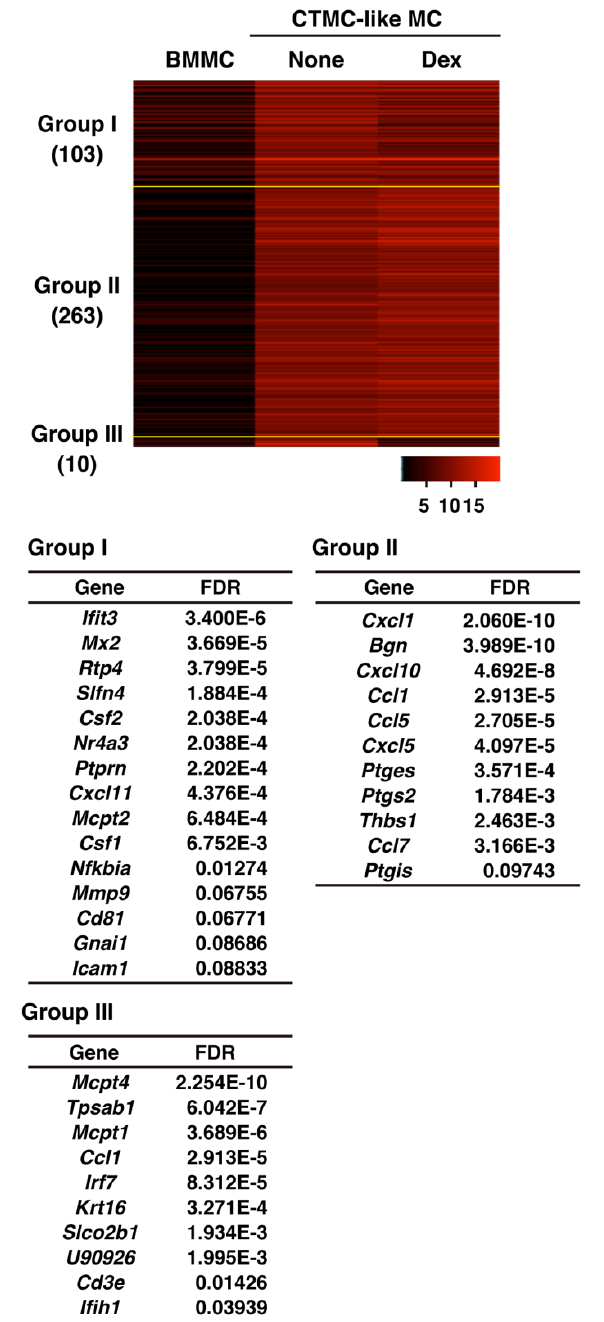
Figure 6. Each RNA sample was collected from the cultured mast cells (BMMCs, connective tissue type mast cell-like cultured mast cells (CTMC-like MCs), and CTMC-like MCs prepared in the presence of Dex) and gene expression analyses were performed by next generation sequencing. Differentially expressed genes between BMMCs and CTMC-like MCs were extracted with the false discovery rate (FDR) <0.1. The heat map presents the expression profiles of the genes, of which expression was increased in CTMC-like MCs. The extracted genes are classified into three clusters based on the expression